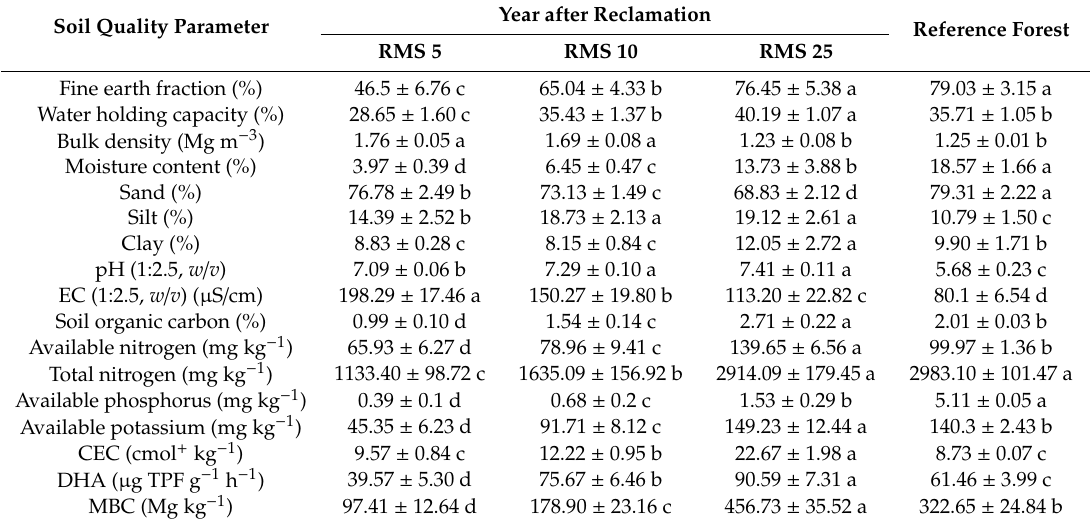
Table 5. Physico-chemical characterization of reclaimed mine soil chronosequence sites and natural forest (mean ± SD, n =